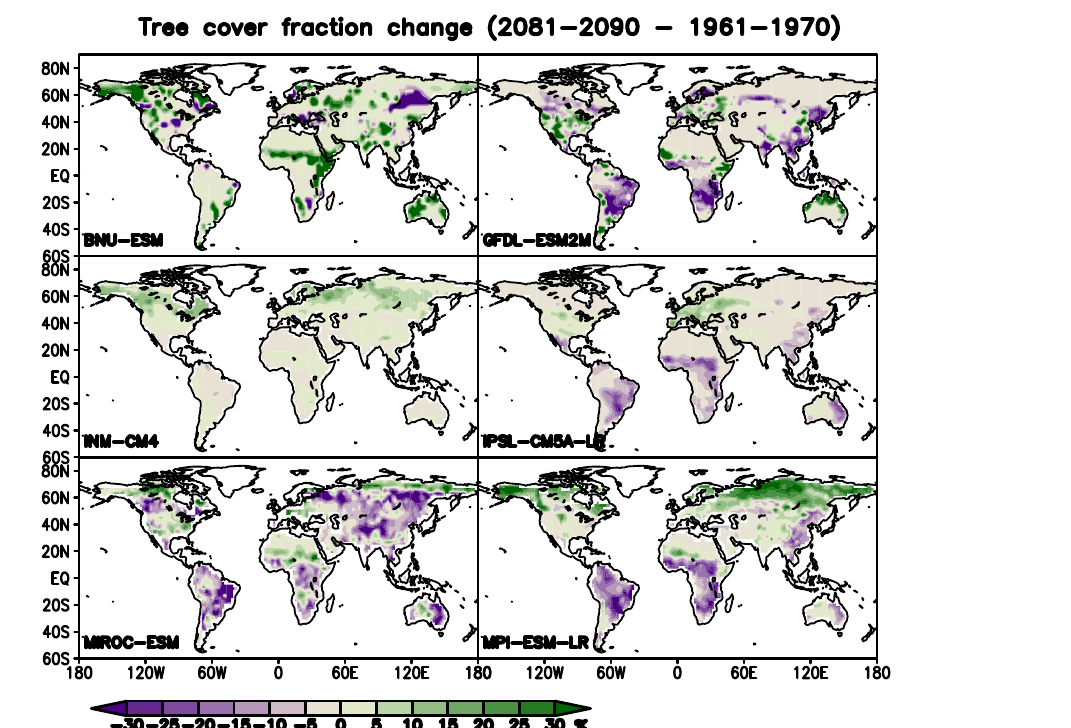
Figure 11. Changes of tree cover fractions between future (2081–2090) and historical (1961–1970) periods from six CMIP5 ESMs. The values represent fractional cover changes relative to the whole grid cell, instead of relative change of tree cover. For MPI-ESM-LR and INM-CM4, tree fraction has increased over wide areas of the northern high latitude regions. For MIROC-ESM, tree fraction has generally decreased over the same regions, possibly in response to a hotter and drier climate